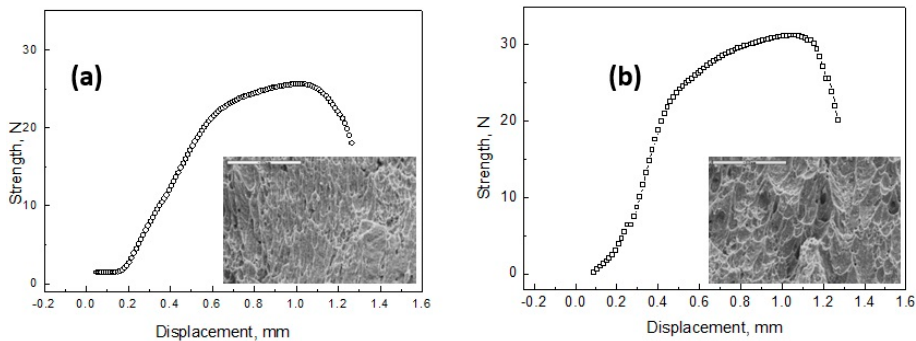
Figure 7. The shear displacement-shear strength curves and the corresponding fracture surface morphology of ( a ) SAC/ Cu and ( b ) SAC/FeNi-Cu joints after reflowing for 270 s.